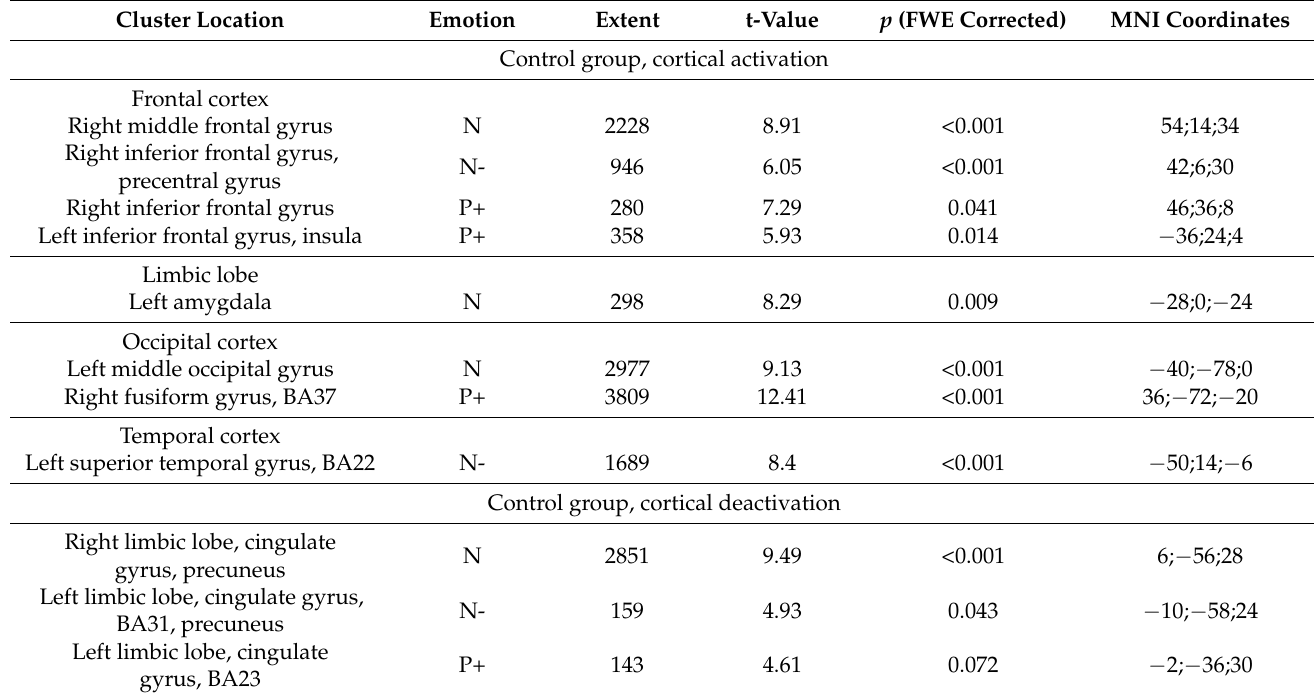
Table 4. Cluster and peak statistics for brain activations and deactivations during facial emotion recognition in healthy controls.